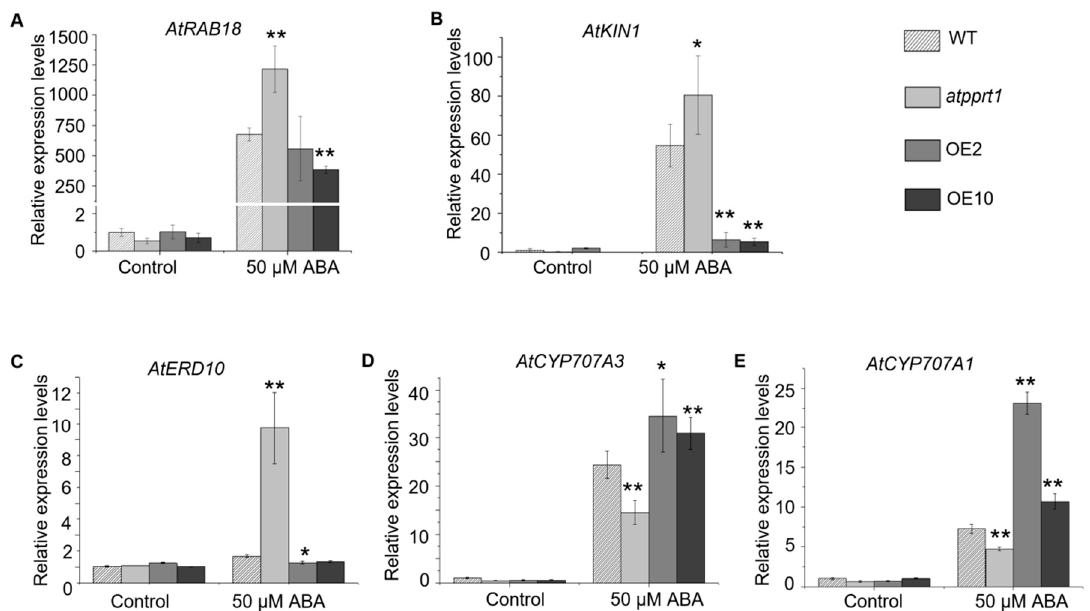
Figure 7. Transcriptional expression levels of stress-inducible genes and ABA hydrolysis genes before and after ABA treatment. Twelve-day-old seedlings were treated with or without 50 µ M ABA for 4 h, and the transcriptional expression levels of AtRAB18 , AtERD10 , AtKIN1 , AtCYP707A1 , and AtCYP707A3 were tested by qRT-PCR analysis. ( A – C ) qRT-PCR analysis of AtRAB18 AtERD and AtKIN1 expression levels in WT, atpprt1 and OE2 and OE10 treated with or without 50 µ M ABA. ( D ) and ( E ) qRT-PCR analysis of AtCYP707A1 and AtCYP707A3 expression levels in WT, atpprt1 and OE2 and OE10 treated with or without 50 µ M ABA. The values are the average of three individual biological replications. Error bars represent ± SD ( n = 3, * p < 0.05, ** p < 0.01, t -test).